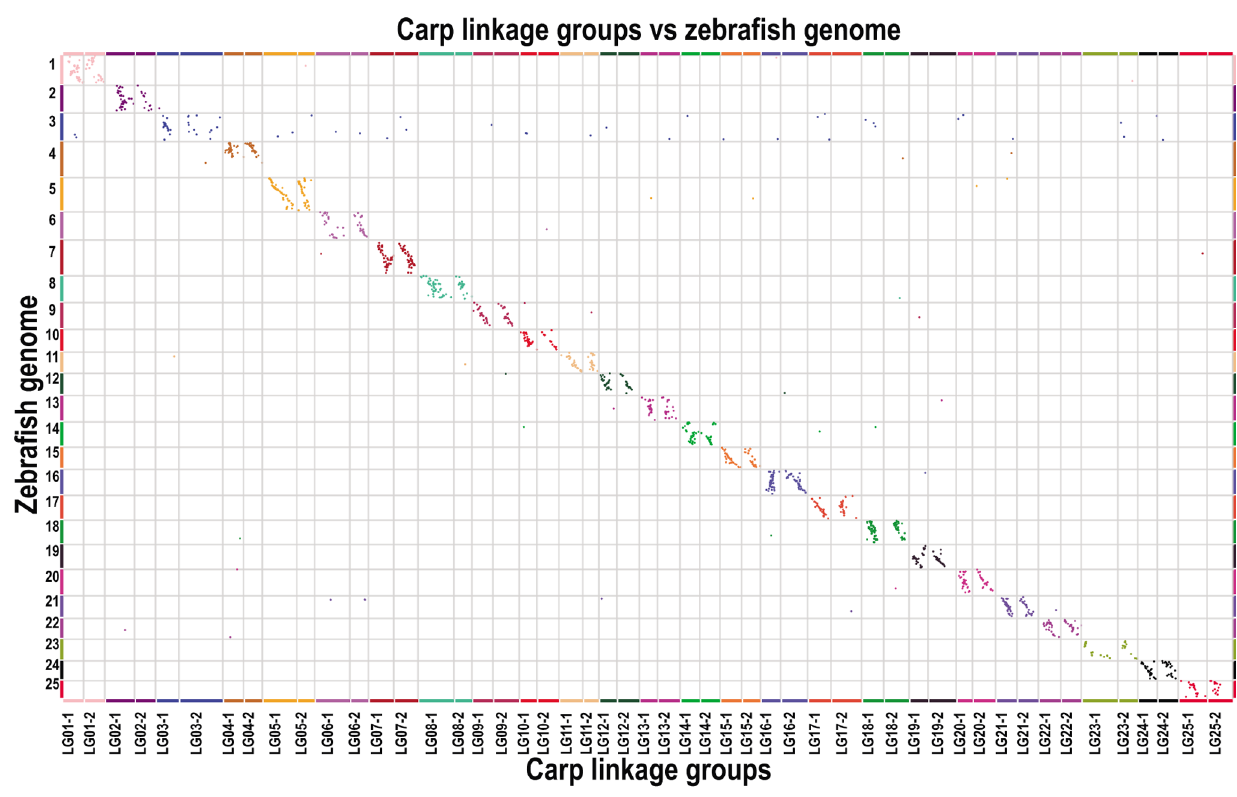
Figure 5. Comparative study between common carp linkage map and zebrafish chromosomes. Two common carp linkage groups corresponded to one zebrafish chromosome.